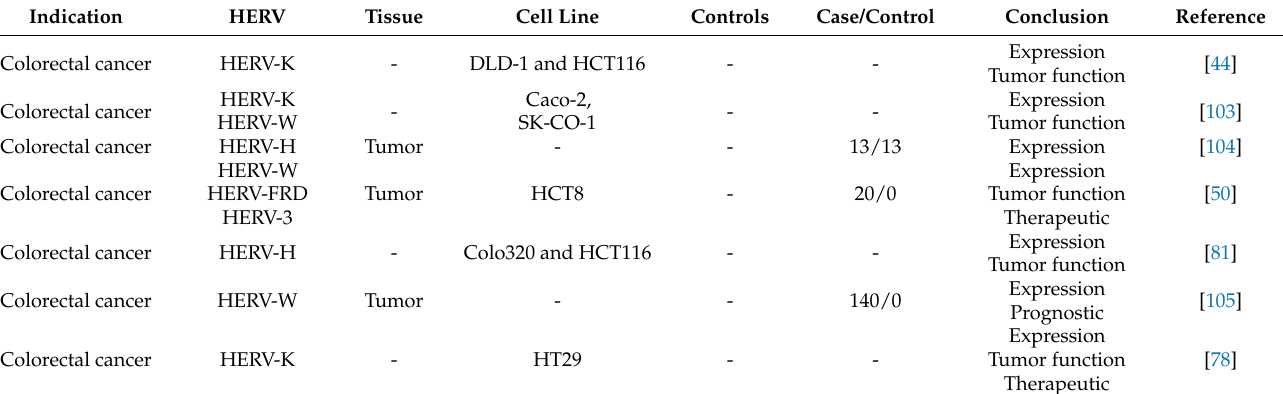
Table 7. HERV protein expression in gastrointestinal